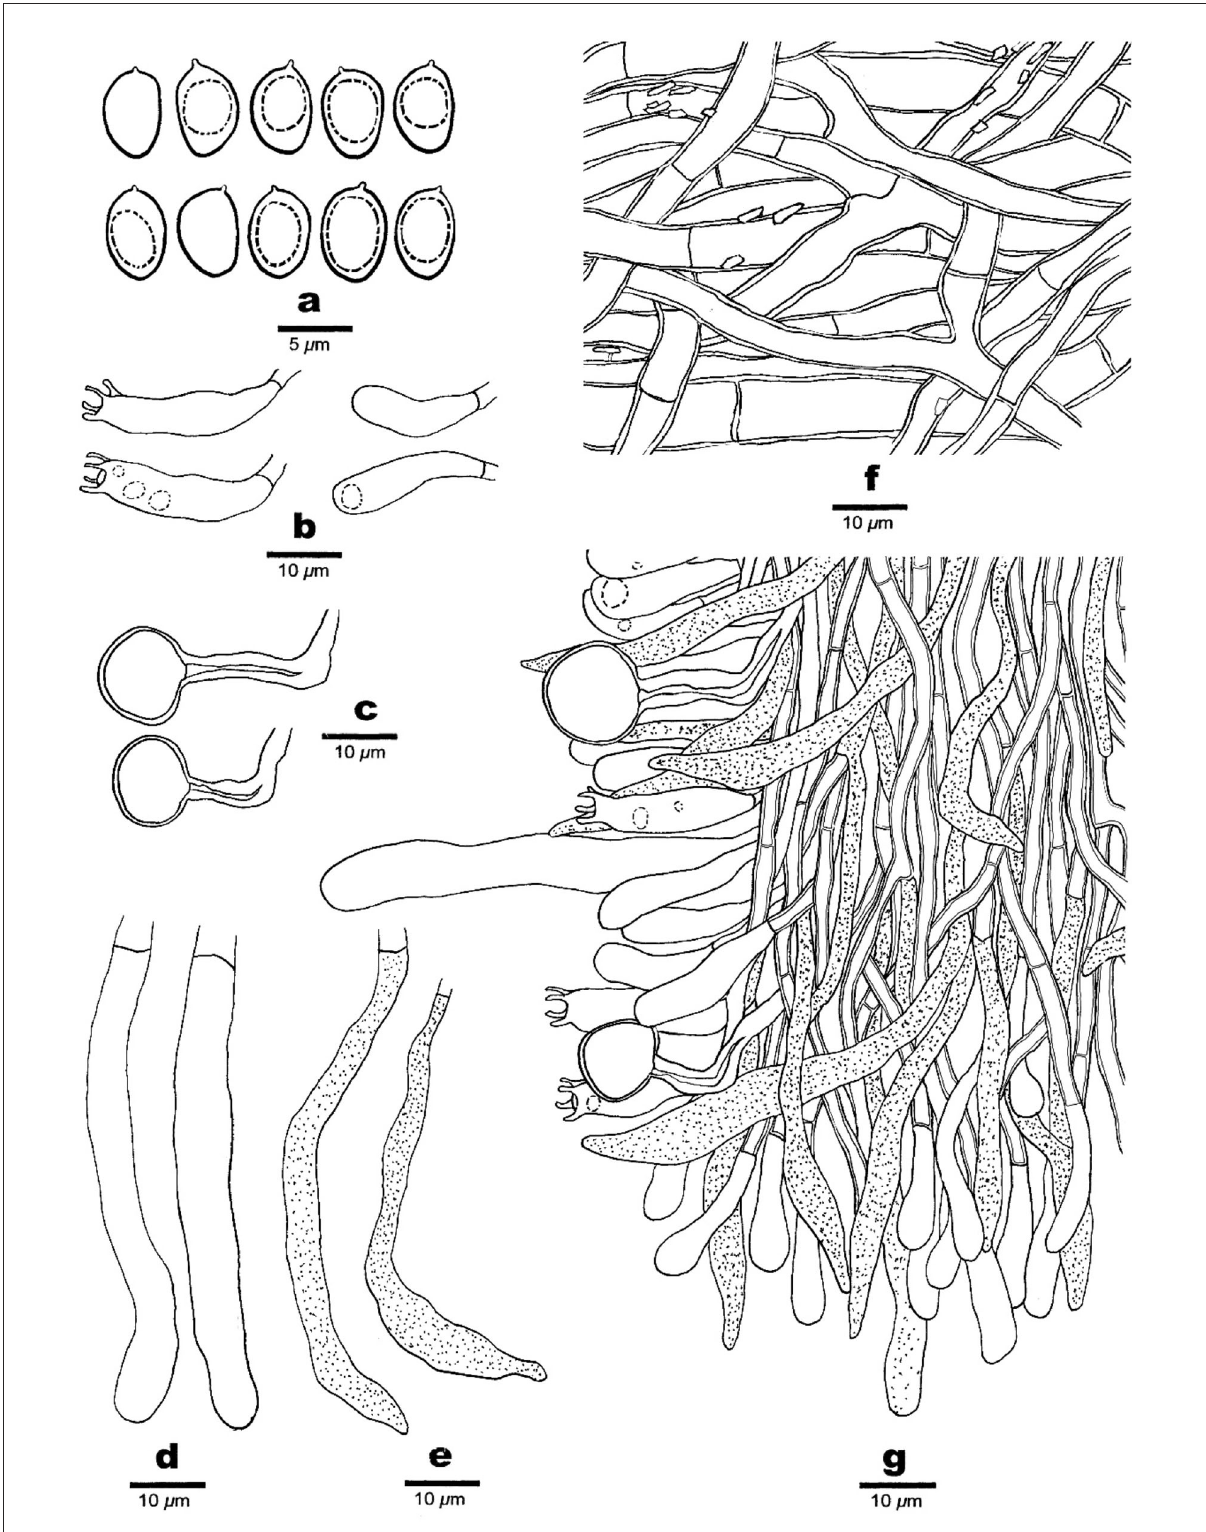
FIGURE3 Microscopic structures of Phaeolus asiae-orientalis (drawn from the holotype, Dai 20867). (a) Basidiospores. (b) Basidia and basidioles. (c) Vascular elements. (d) Cystidia. (e) Gloeocystidia. (f) Hyphae from context. (g) A section from tube